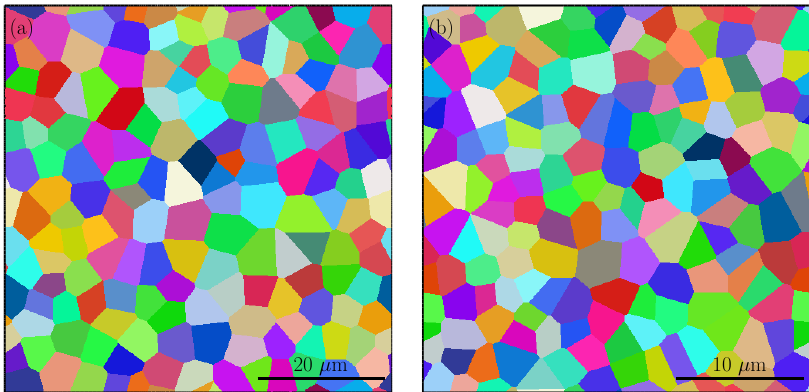
Figure 4. RVEs used to model ( a ) ferrite, ( b ) martensite. Colors represent the Voronoi cells with different grain